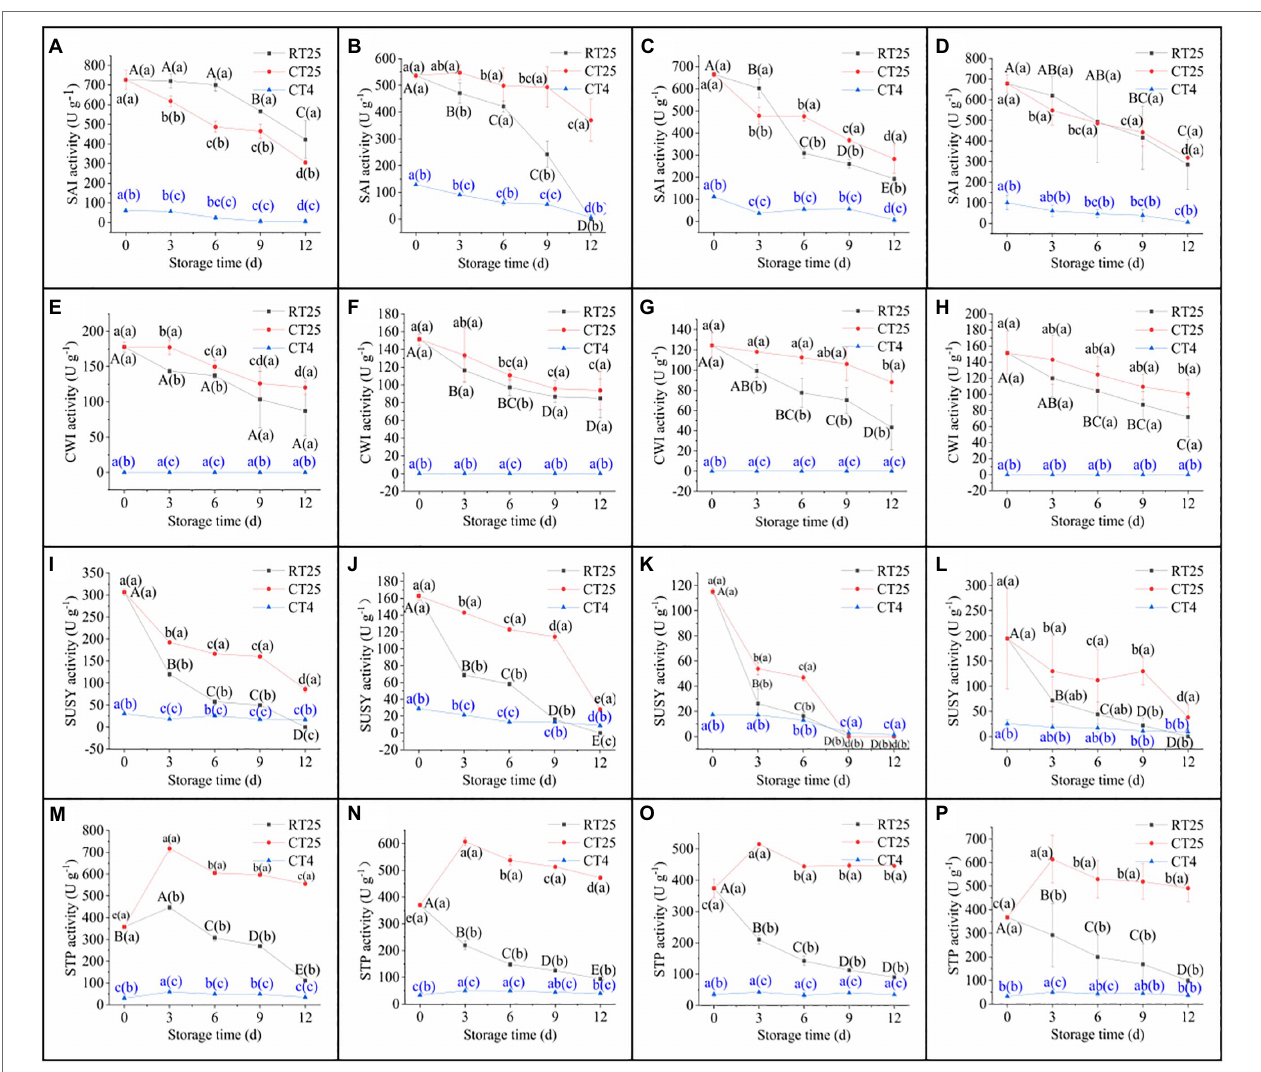
FIGURE 7 | Activity of sucrose- and starch-catabolizing enzymes in bamboo shoots during storage at 25 ° C and 4 ° C. RT25, bamboo shoots stored at room temperature and analyzed at 25 ° C; CT25, bamboo shoots stored at cold temperatures and analyzed at 25 ° C; and CT4, bamboo shoots stored at cold temperatures and analyzed at 4 ° C. (A–D) Dynamic changes in SAI activity in shoots during storage for upper (A) , middle (B) , and bottom (C) plant parts, and mean values (D) . (E–H) Dynamic changes in CWI activity in shoots during storage for upper (E) , bottom (F) , and bottom (G) plant parts, and mean values (H) . (I–L) Dynamic changes in SUSY activities in shoots during storage for upper (I) , middle (J) , and bottom (K) plant parts, and mean values (L) . (M–P) Dynamic changes in STP activity in shoots during storage for upper (M) , middle (N) , and bottom (O) plant parts, and mean values (P) . Data are presented as mean ± standard deviation ( n = 3). Significant analysis was performed using the Student’s t -test, in which different letters represent significant difference between treatments within the group, and the different letters in brackets represent the level of significance between groups (see also of Figure 10